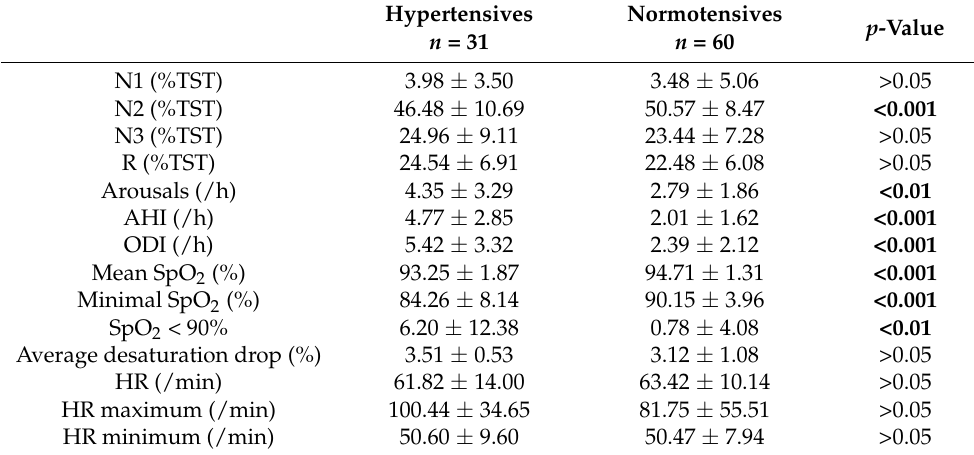
Table 4. Polysomnographic parameters determined in the study group and control group.